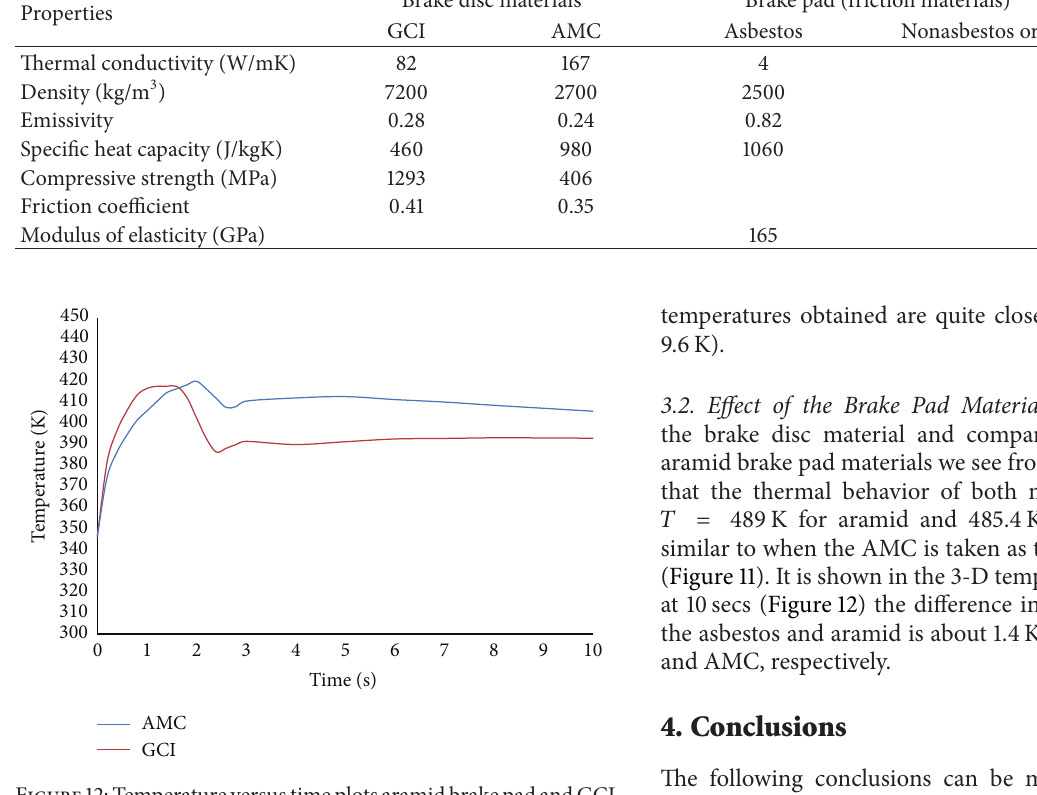
Figure12:TemperatureversustimeplotsaramidbrakepadandGCI and AMC brake discs.